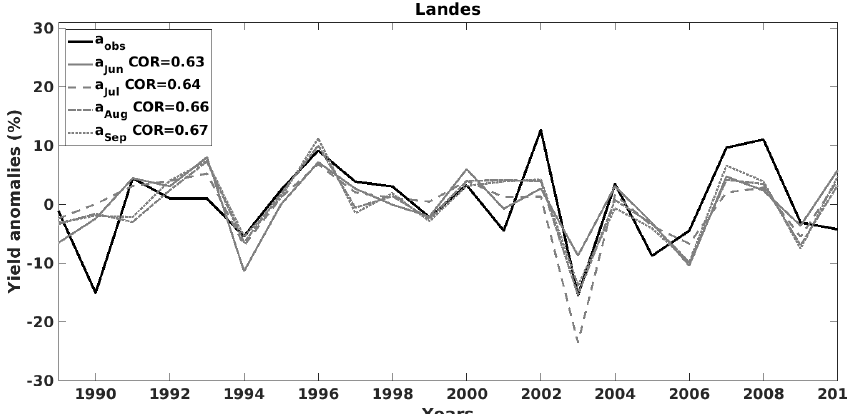
Figure 13. The observed ( a obs ) and the estimated yield anomalies time series, for different forecasting months from June to September (e.g. a Jun means June forecasting), for grain maize in Landes